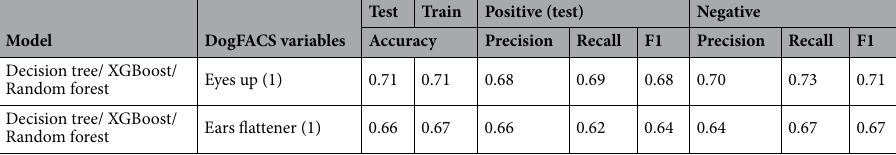
Table 3. Single DogFACS variable predictive